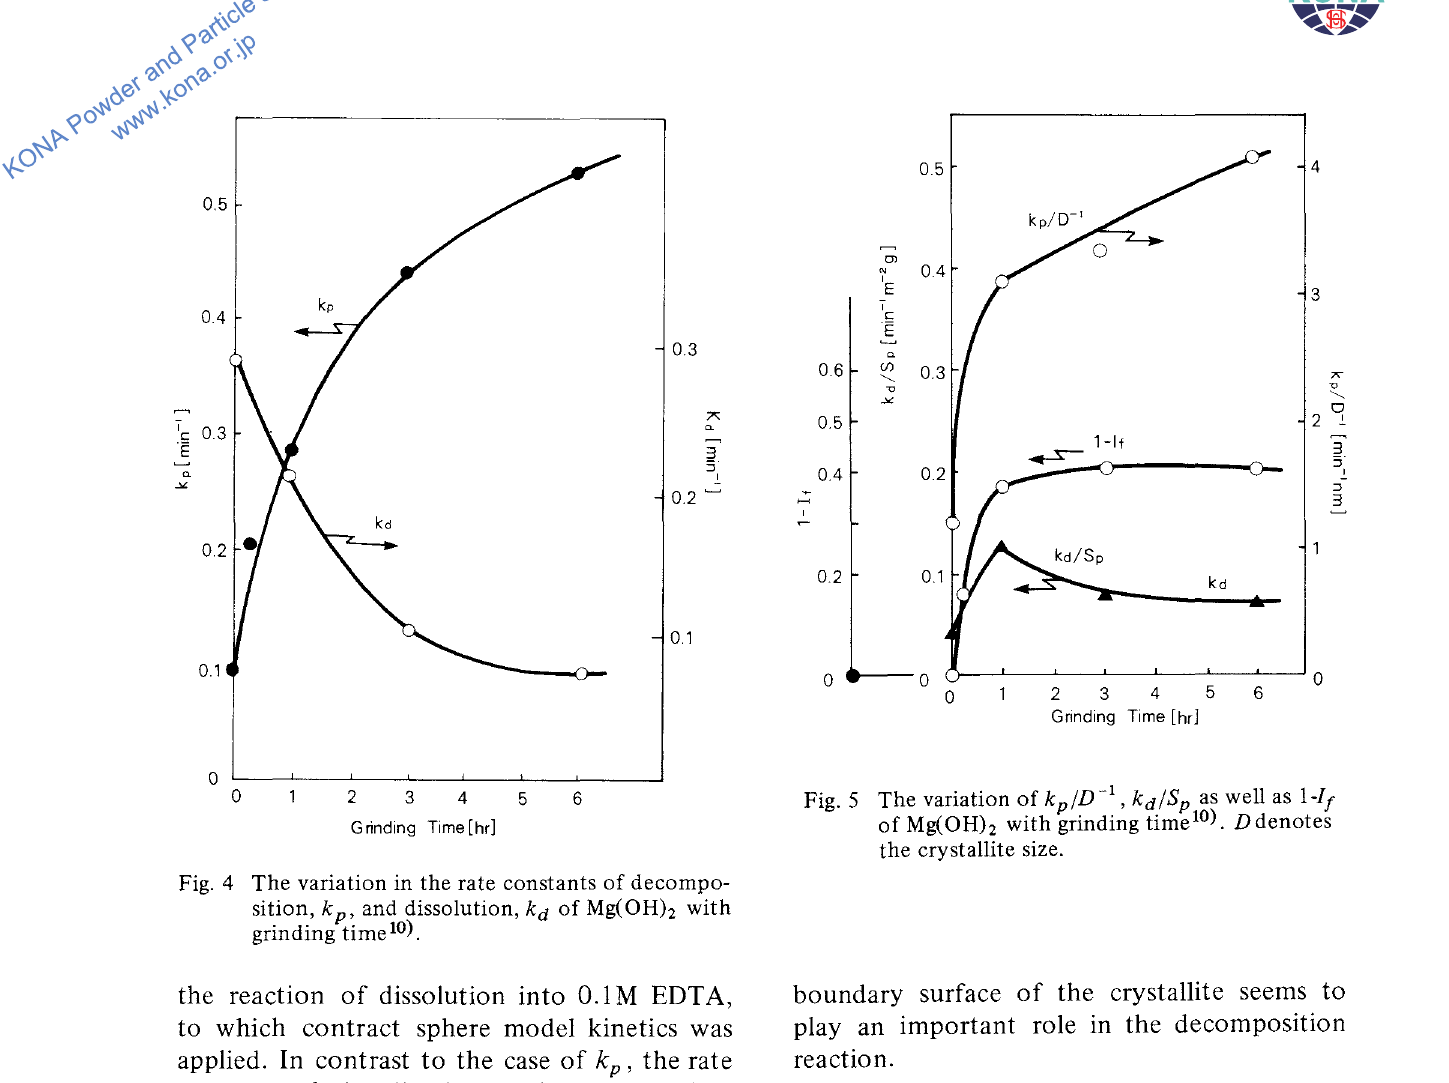
Fig. 4 The variation in the rate constants of decompo sition, kp, and dissolution, kd of Mg(OHh with grinding time 10).